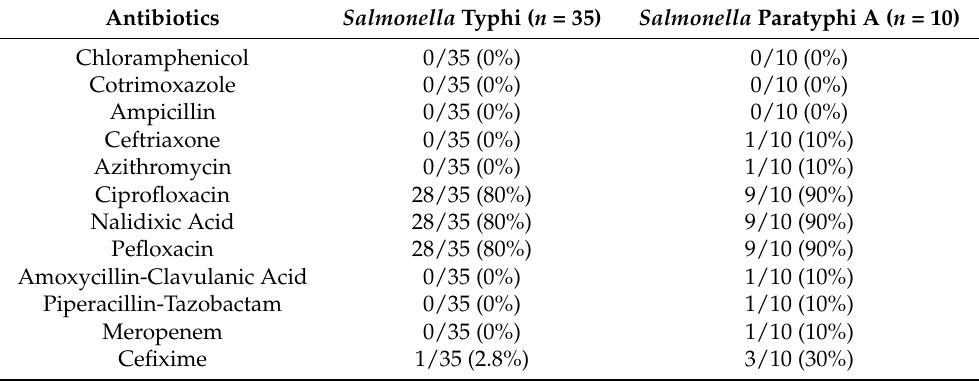
Table 4. Percentage of resistance of the Salmonella isolates to fluoroquinolones and other clinically important antibiotics that are mentioned in this study from 2017 to